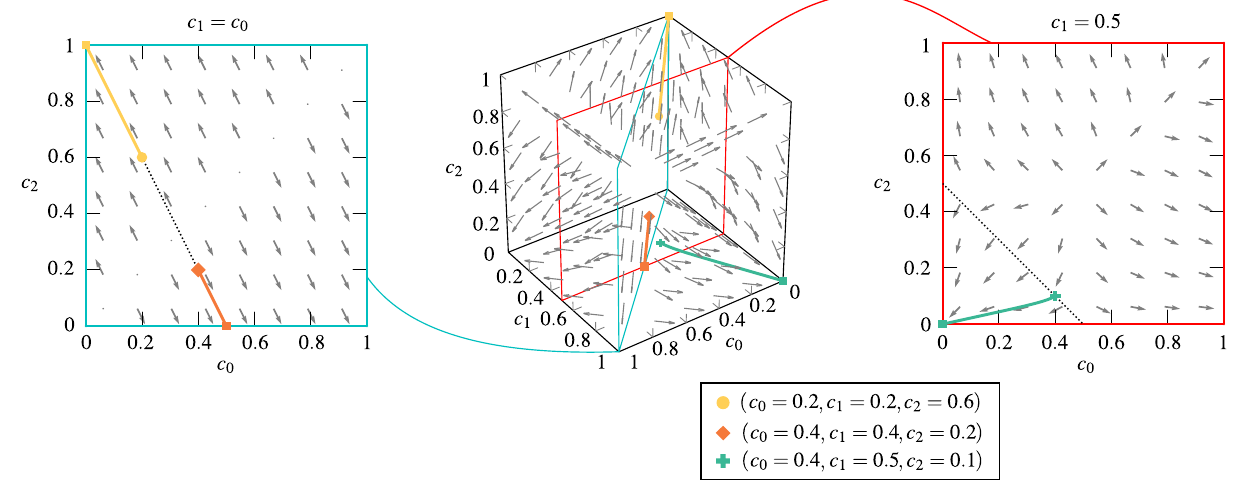
Figure 4. Flow diagrams for the annealed model with s = 3 states, the group of influence q = 5 and probability of independence p = 0 obtained from Eq. (7). Arrows indicate the direction of the flow in the system. Squares refer to stationary points, whereas other markers represent initial points, as indicated in the legend. Lines that connect them represent trajectories. Space for clarity is presented for c 0 , c 1 , c 2 ∈ [ 0, 1 ] as independent variables, whereas dotted lines on insets represent possible initial conditions which fulfill condition c 0 + c 1 + c 2 = 1